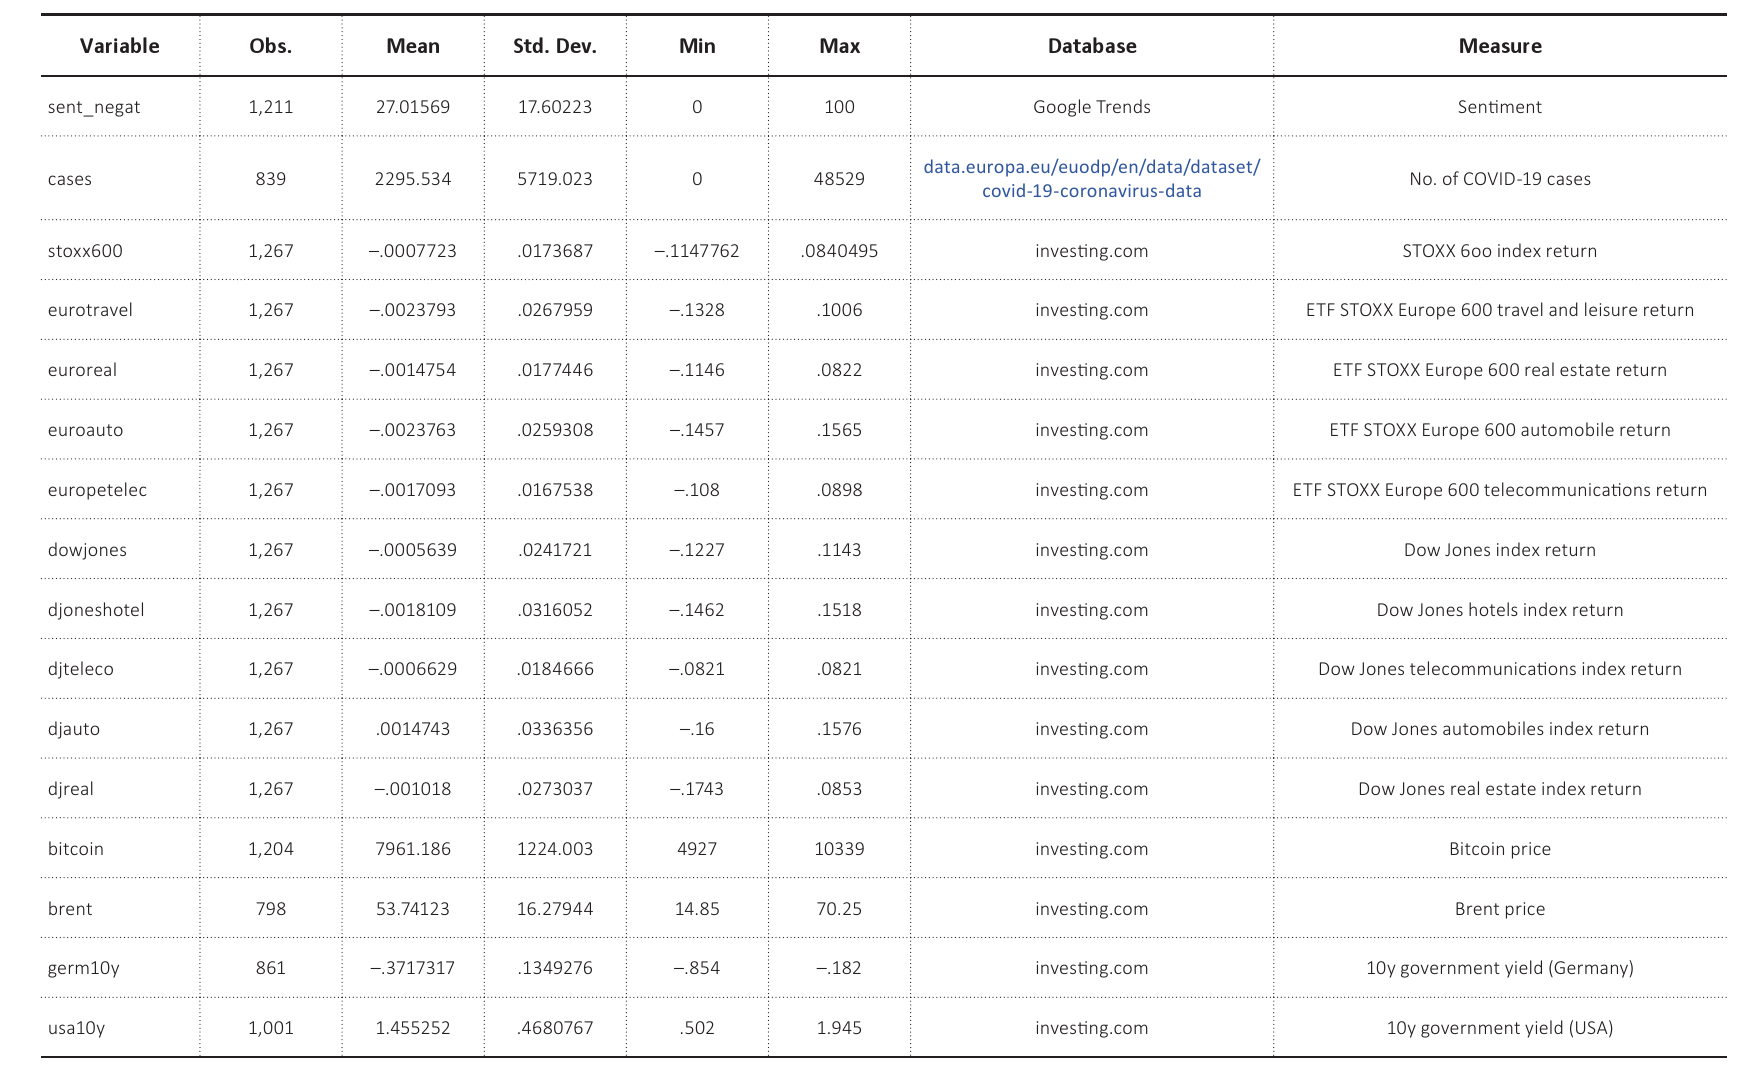
Table 2. Summary statistics and variable